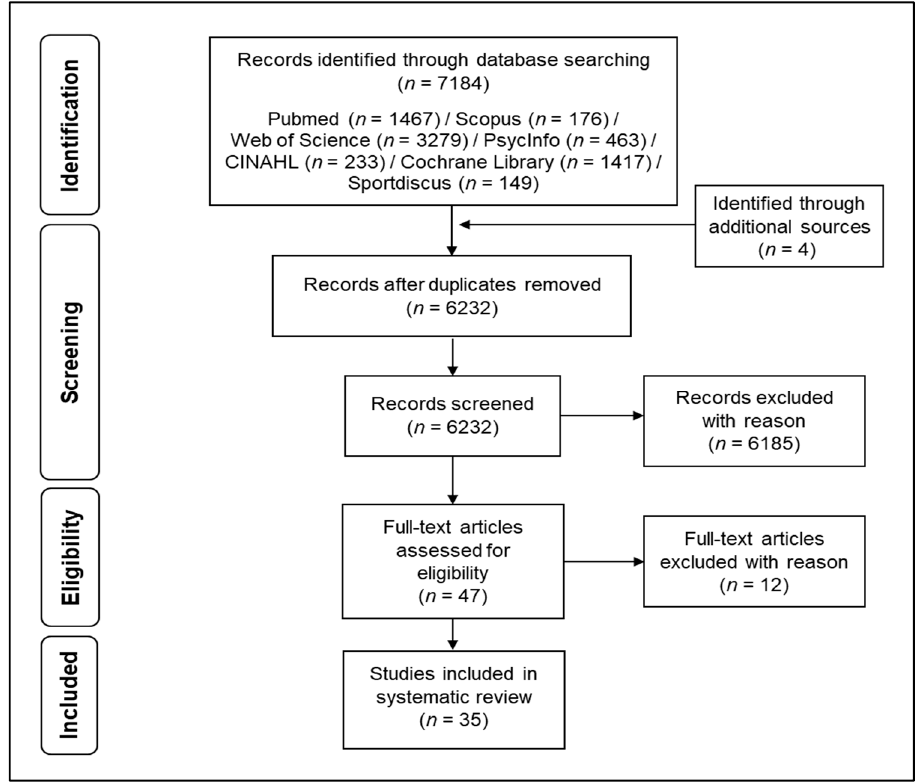
Figure 3. Flow chart with information about the search, screening, and selection processes, which led to the identification of relevant articles included in this review.